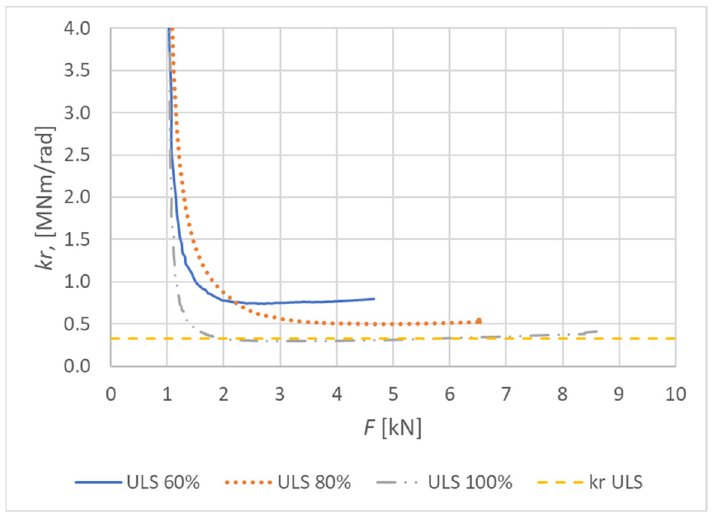
Figure 17. Course of rotational stiffness of a semirigid connection for specimens made from a combination of bolts and dowels (Experiment A).